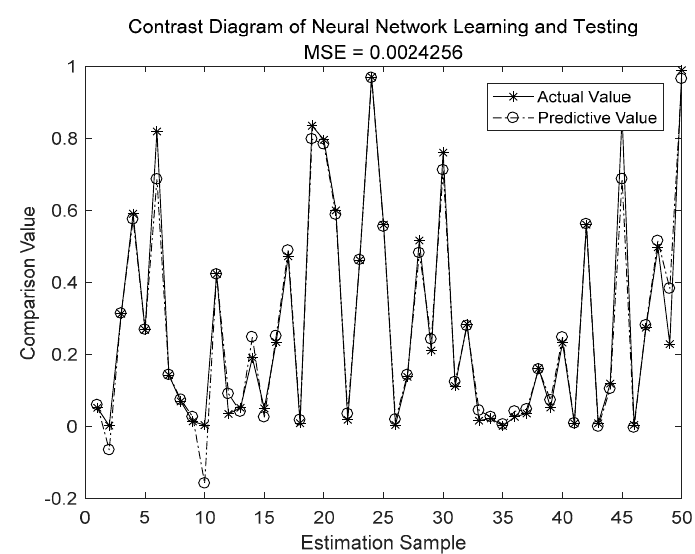
Figure 8. Actual and predictive outputs of extreme learning machine (ELM).